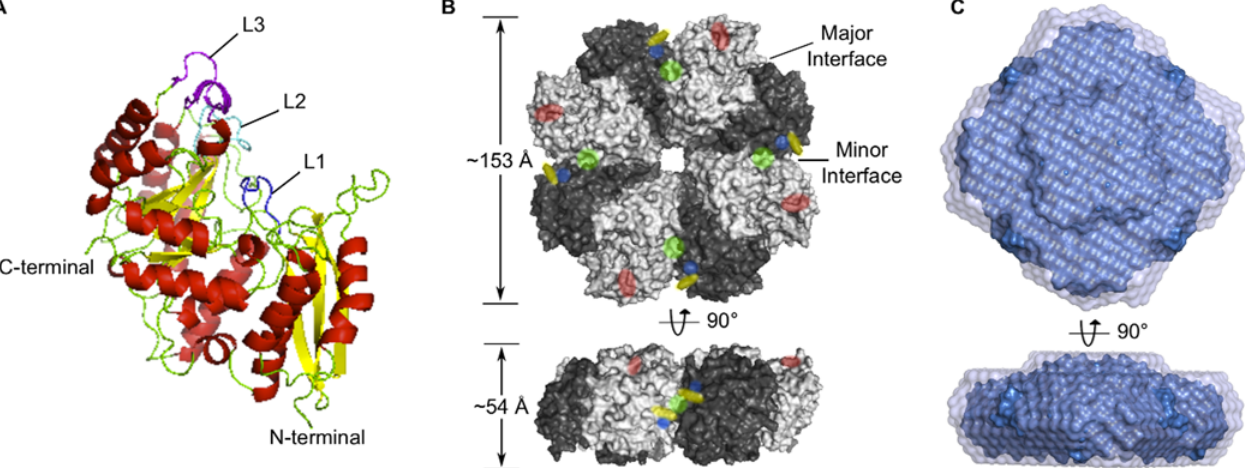
Fig 1. Structure of streptococcal α -enolase. ( A ) Structure of a monomeric unit of SEN. The three loop regions L1, L2 and L3 are colored blue, cyan and magenta, respectively. The elements of secondary structure are colored red ( α -helices) and yellow ( β -sheets). ( B ) Structure of SEN octamer. The major and minor interfaces are labeled. BS1 and BS2 are colored blue and red, respectively; and lysine residues mutated in this study are colored yellow (K312) and green (K362). ( C ) Results of ab initio modeling from SAXS data. A dummy residue model is shown in solid blue within the averaged spread region, shown in transparent purple, for a similar cluster of bead models.